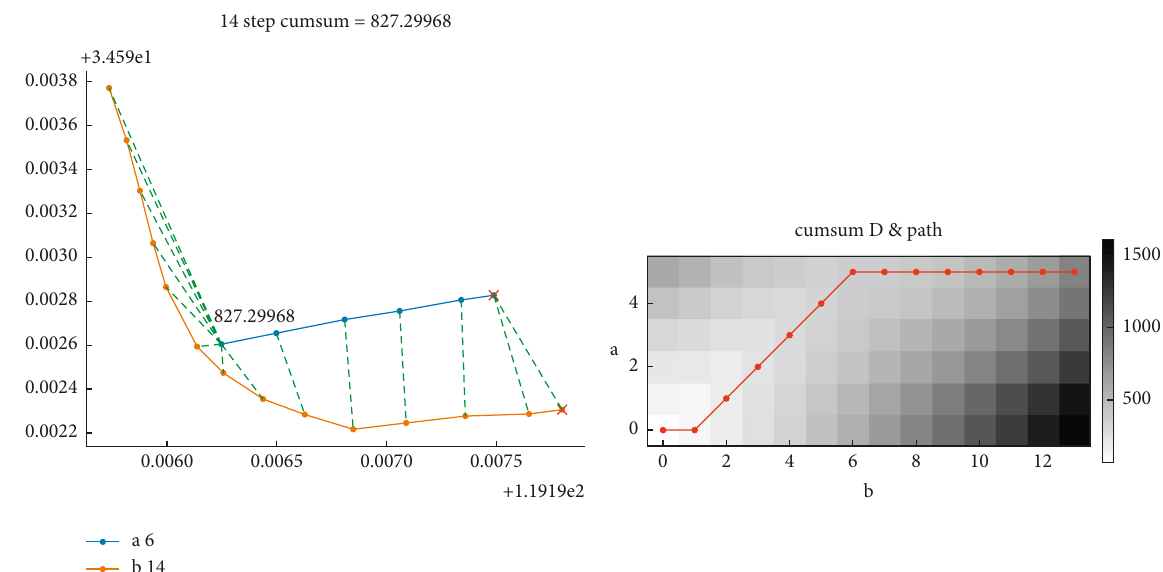
Figure 5: Spatial distribution and matched pairs diagram of traditional DTW between two series a and b